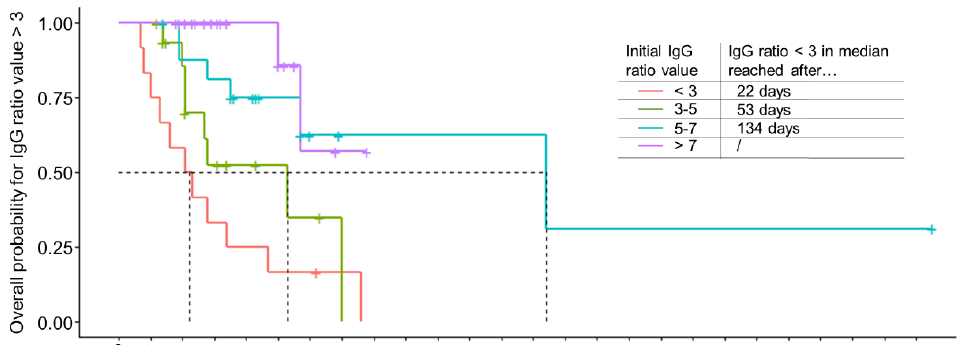
Figure 6. High SARS-CoV-2 anti-S IgG ratio values allow longer CP donation periods. Time-to-event analysis for four different groups of IgG ratio values: <3 ( n = 12), 3–5 ( n = 16), 5–7 ( n = 18) and >7 ( n = 20) was conducted. Data shown are overall probabilities for a drop of the IgG ratio value below the value of 3 over time given in days (median values are indicated by dashed lines), log-rank p < 0.0001.